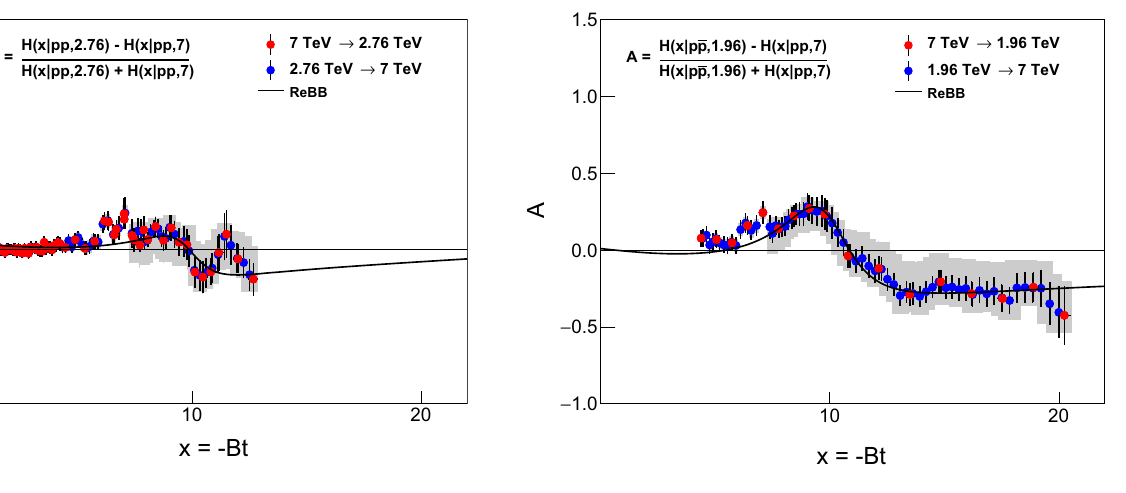
Fig. 17 Within experimental errors, the asymmetry parameter of elas- √ Fig. 18 Within experimental errors, the asymmetry parameter of elas- √ s = 2 . 76 and 7 TeV, indicating, that tic pp scattering vanishes for s 1 = 1 . 96 and 7 TeV, tic p ¯ p versus pp scattering does not vanish for H ( x ) scaling is valid within the experimental errors. The solid line is indicating, that the Odderon contribution is significant, larger than the the result of a model calculation based on the full version of the Real experimental errors. The solid line is the result of a model calculation Extended Bialas–Bzdak model of Ref. [42], it indicates that the scaling based on the full version of the Real Extended Bialas–Bzdak model of violations are well under theoretical control in this calculation Ref. [42], it indicates that the H ( x ) scaling violations are well under theoretical control in this calculation, not only for the pp case, demon- strated in Fig. 17, but also for the p ¯ p case, demonstrated on this